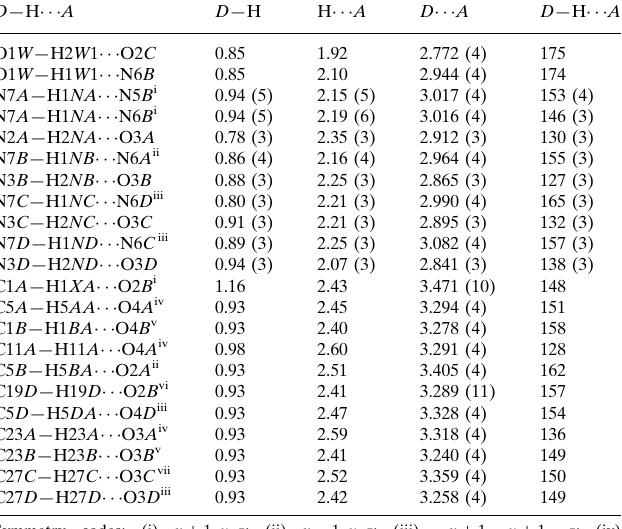
Hydrogen-bond geometry (A˚ , (cid:3)